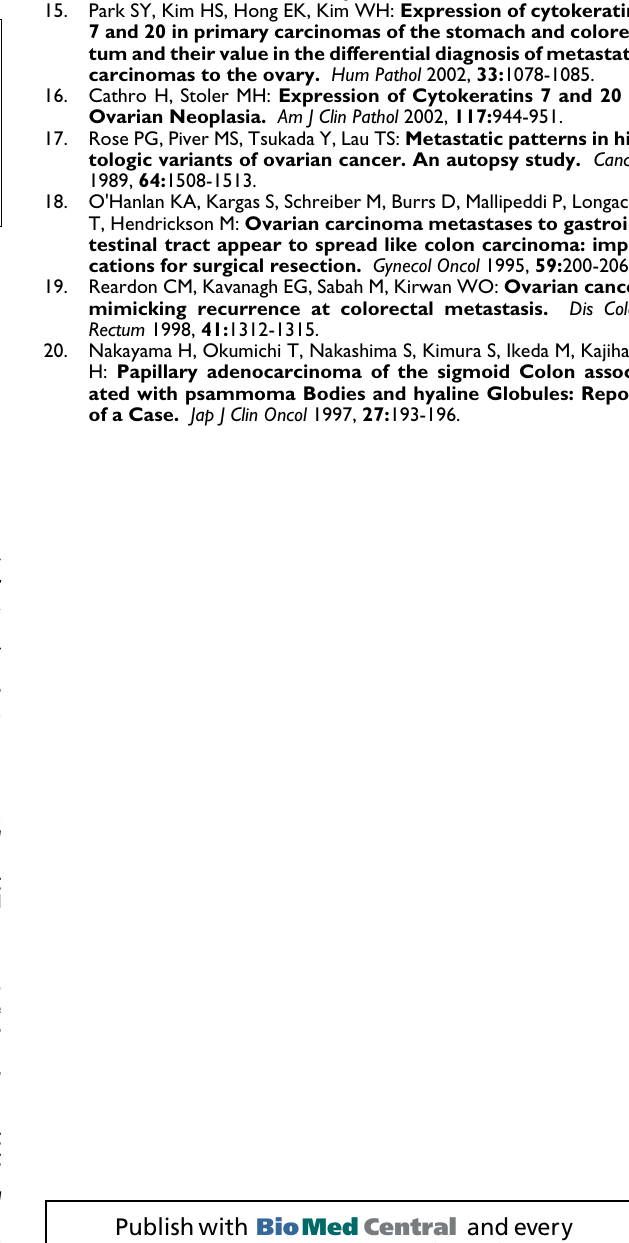
Table 1. Clinicopathological features of 20 cases of ovarian involvement by colorectal adenocarcinoma and